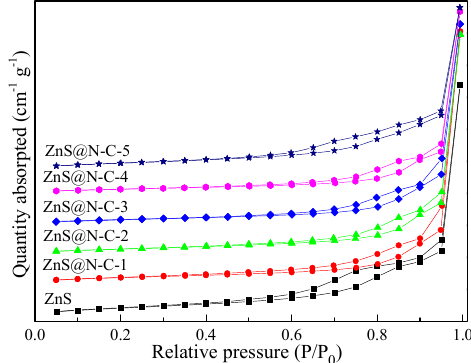
Figure 4. N 2 adsorption–desorption isotherms of ZnS and ZnS@N-C composites. Table 1. Surface parameters of ZnS and ZnS@N-C samples. Samples